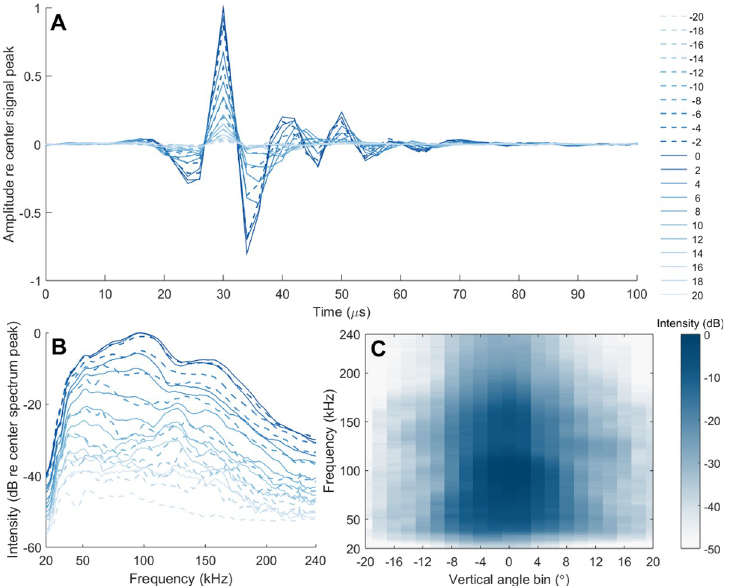
Fig 6. Mean angular variation for 351 non-edge clicks for beluga echolocation click (A) waveforms and (B, C) spectra. For all non-edge clicks selected where the RL of maximal intensity was not recorded at one of the outermost receivers, signals were received at various angles along the vertical hydrophone array where the center of the beam was at 0˚. Angle bins between -20 to 20˚ (negative is dorsal; positive is ventral) show signal differences measured farther from the acoustic axis. The heatmap (C) in dB re center (0˚) spectrum peak shows angle bin (˚) and frequency ranges for the highest (dark blue) and lowest (white) spectral energy.